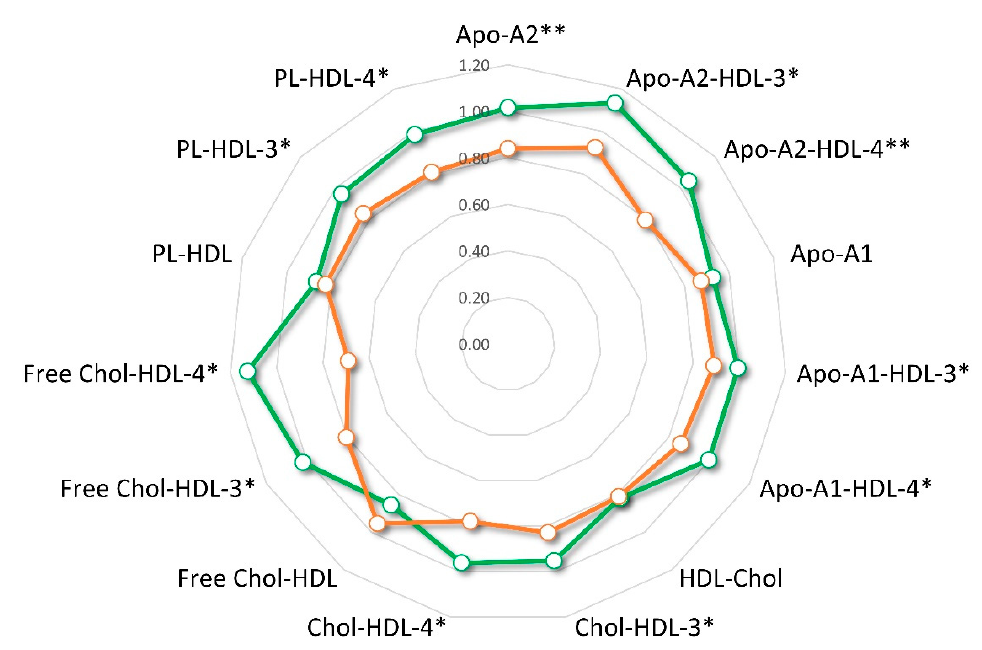
Figure 8. Radar plot of plasma HDL subfractions’ changes after 3 months (T2) of NACT as compared with baseline (T1) in complete (CR, green) and partial response (PR, red) patients. ** p < 0.01; * p < 0.05.